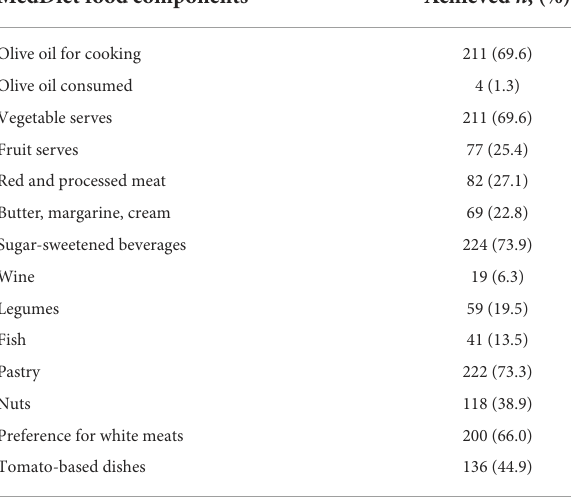
TABLE 2 Proportion of participants achieving normative criteria for each individual MEDAS question.